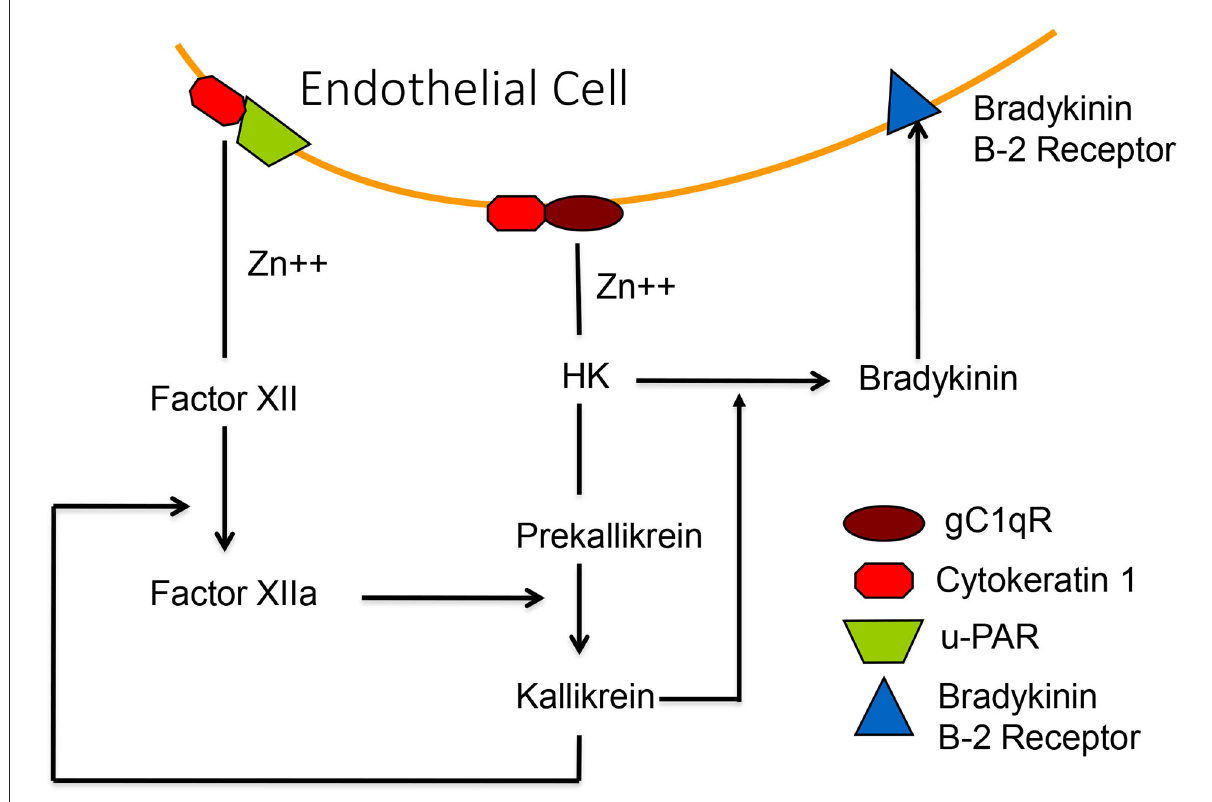
FIGURE7 A diagrammatic representation of the zinc-dependent binding of HK-prekallikrein and factor XII to the surface, employing primarily complexes of gC1qR-cytokeratin-1 and cytokeratin 1—uPAR, respectively. Activation of factor XII, or activation of HK-prekallikrein by HSP 90, results in the formation of both factor XIIa and kallikrein. The latter digests HK to release bradykinin which binds to the B-2 receptor to increase vascular